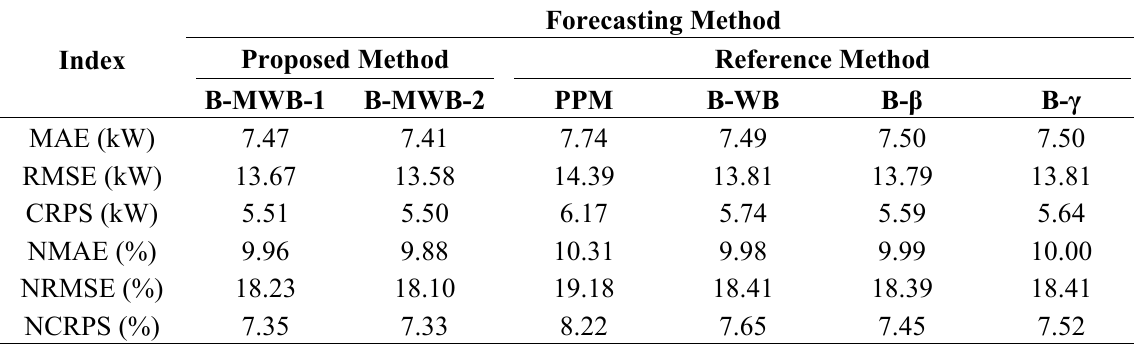
Table 3. Time-series TS1: Values of absolute and percentage indices for the forecasts averaged from 14 June 2013 to 12 August